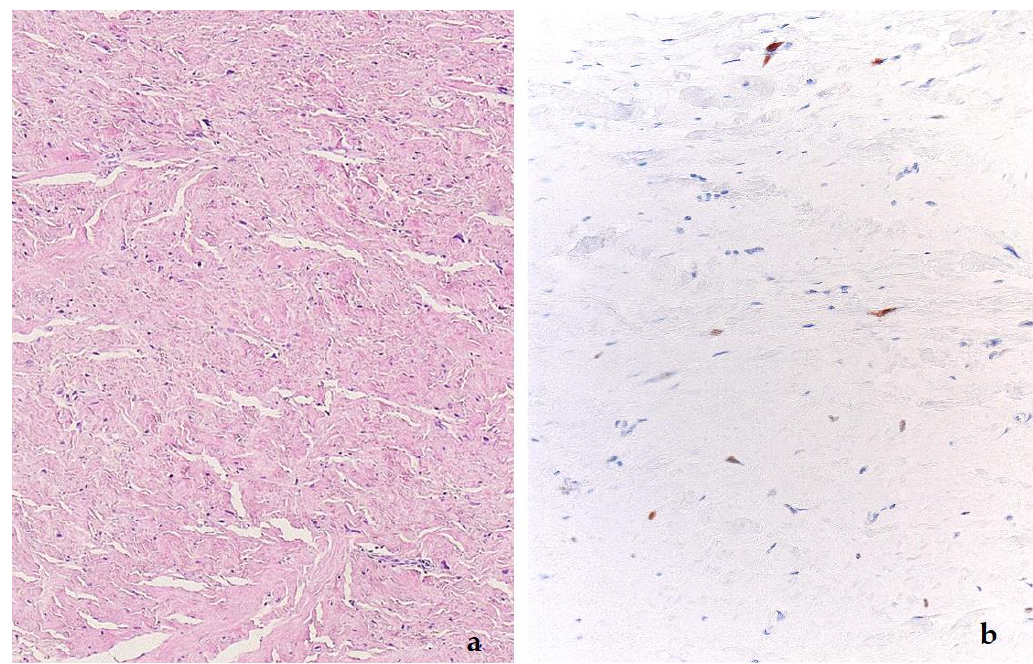
Figure 8. Scar-like phenotype of a dedifferentiated liposarcoma, H&E ( a ), and MDM2 stain ( b ).